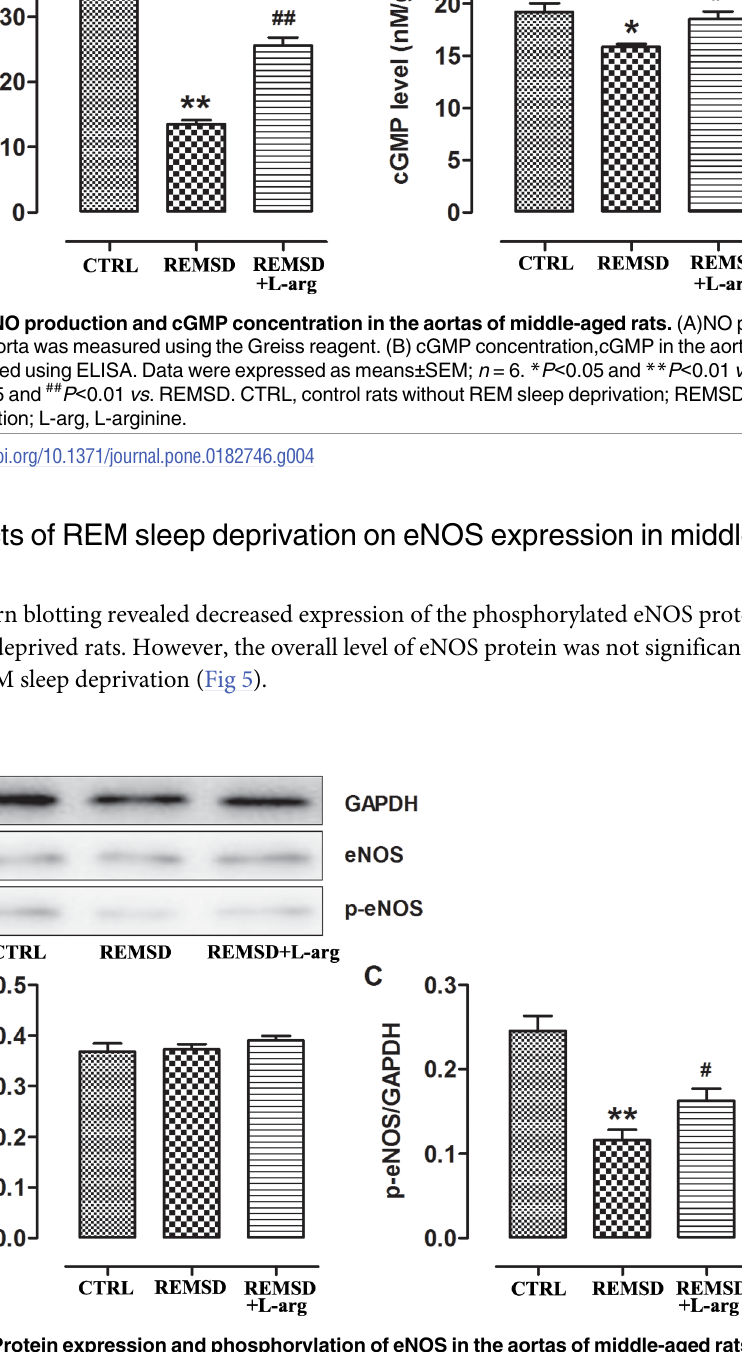
Fig 5. Protein expressionand phosphorylation of eNOS in the aortas of middle-aged rats. Protein expressionlevels in the aorta were measured via (A)western blotting. (B and C)Chemiluminescentsignals were detected and analyzedusing the ChemiDoc XRS Imaging System.Data were expressedas means ± SEM; n = 6. * P < 0.05and ** P < 0.01 vs . CTRL; # P < 0.05 vs . REMSD. CTRL, control rats without REM sleep deprivation; REMSD, REM sleep deprivation;L-arg,